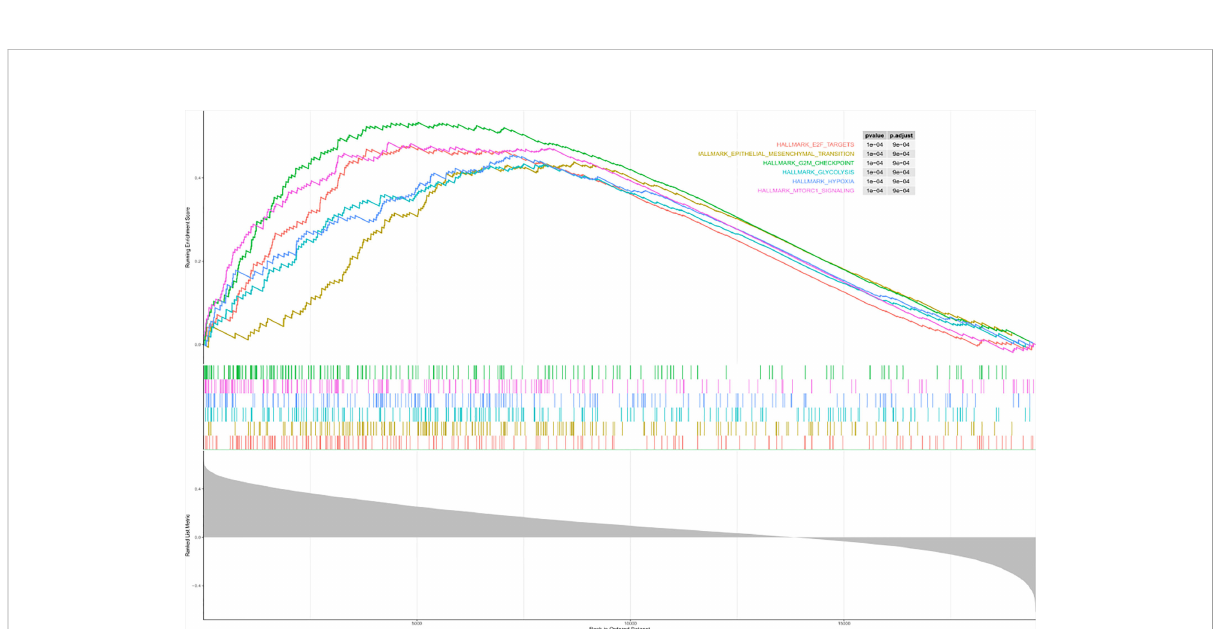
FIGURE 7 Results of the gene set enrichment analysis. There were six pathways based on the enrichment analysis, and they were respectively E2F targets, epithelial – mesenchymal transition, G2M checkpoint, glycolysis, hypoxia, and mTORC1